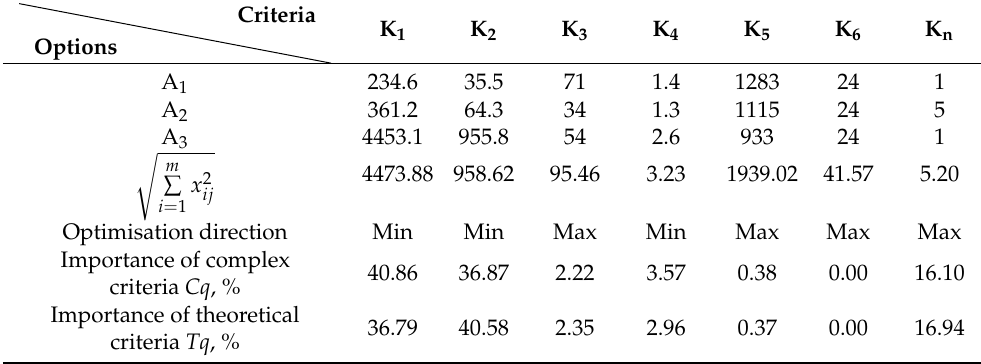
Table 21. The initial Matrix M of alternative